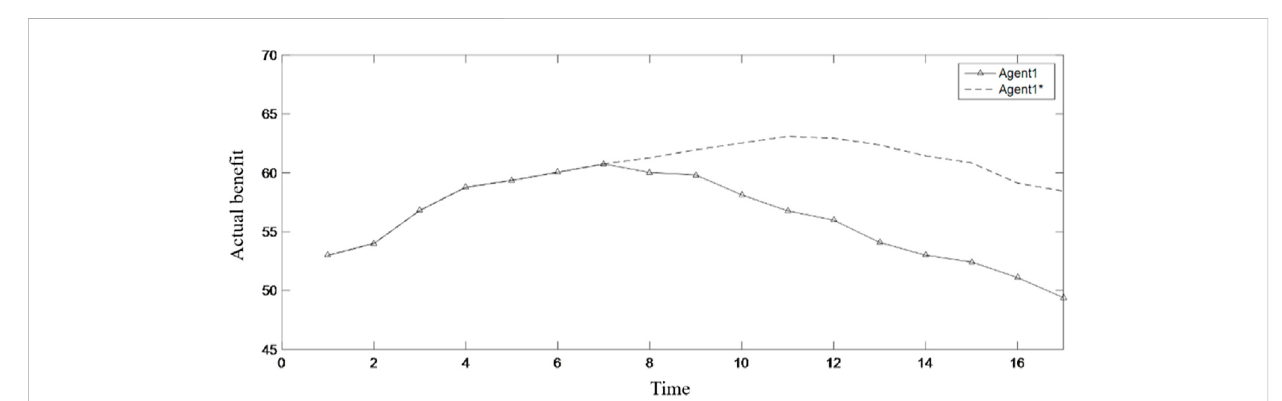
FIGURE 8 Impact of inhibitory factors on the actual bene fi ts.